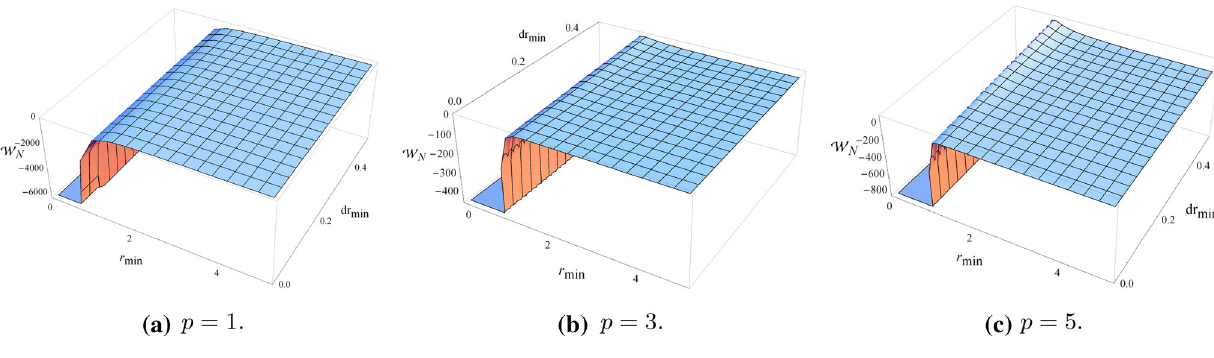
Fig. 3 The value of W N for l = 1, Q = 2, (cid:4) D − 2 =